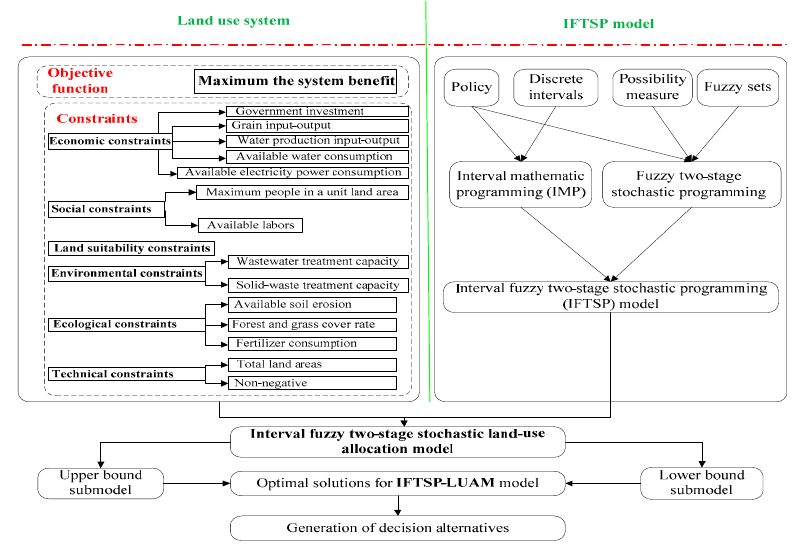
Figure 2. Framework of IFTSP-LUAM.